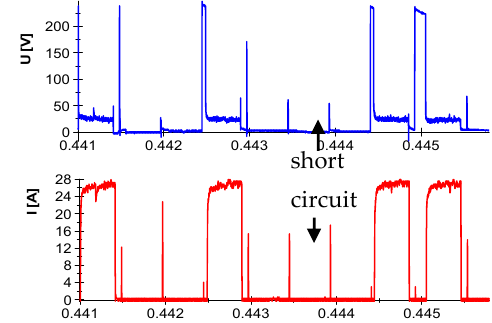
Figure 3. The recorded current and voltage waveforms.